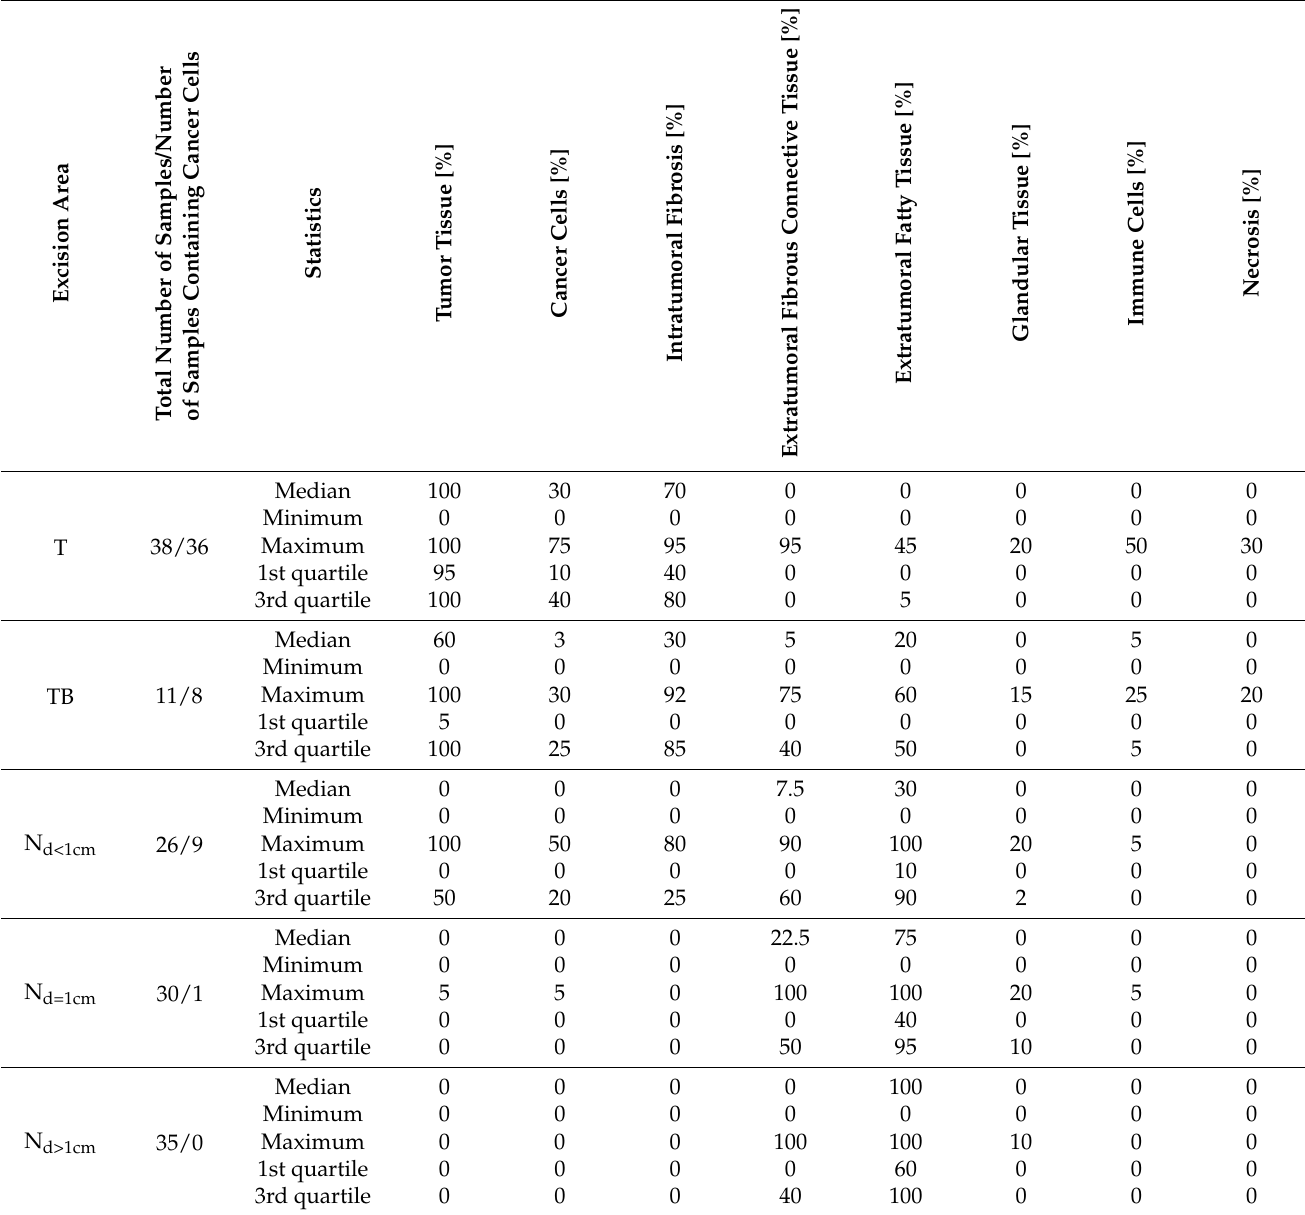
Table 2. The tissue contents of the samples collected at the T, TB, N d<1cm , N d=1cm and N d>1cm